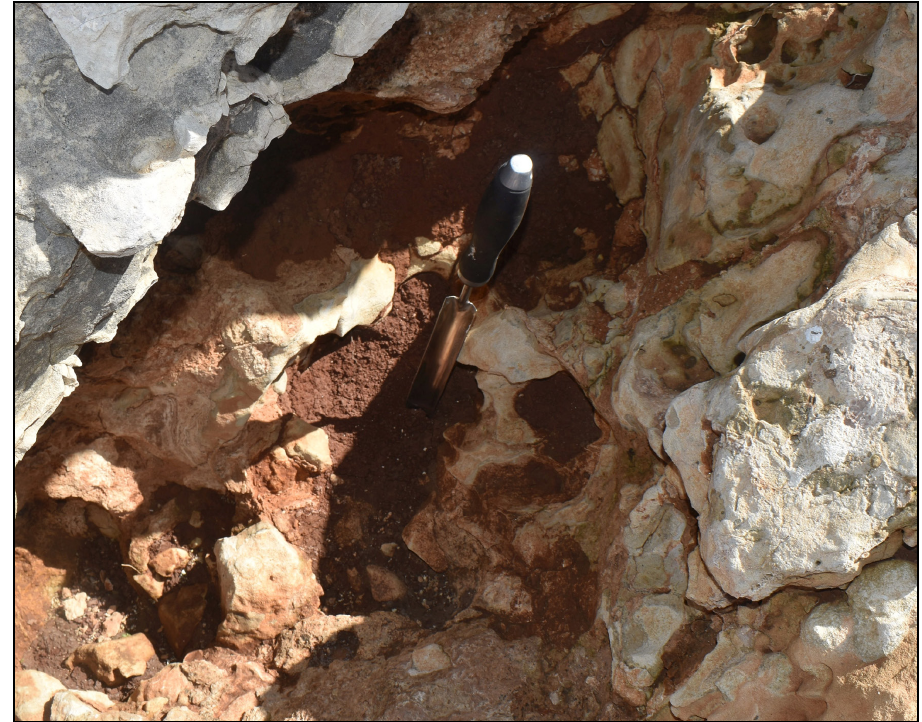
Figure 5. Karst solutional features beneath the land surface at the boulder berm. The crevice and associated solutional pipes are filled with terra rossa soil, indicative of long-term weathering of the surface